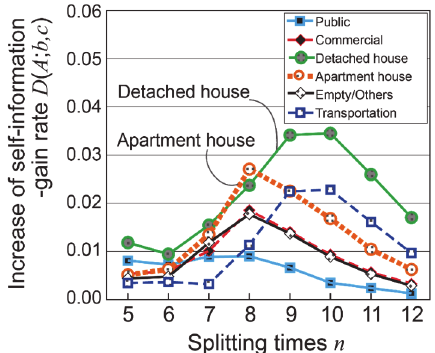
Figure 15 . Self-information-gain rate increase for “detached house” lots.